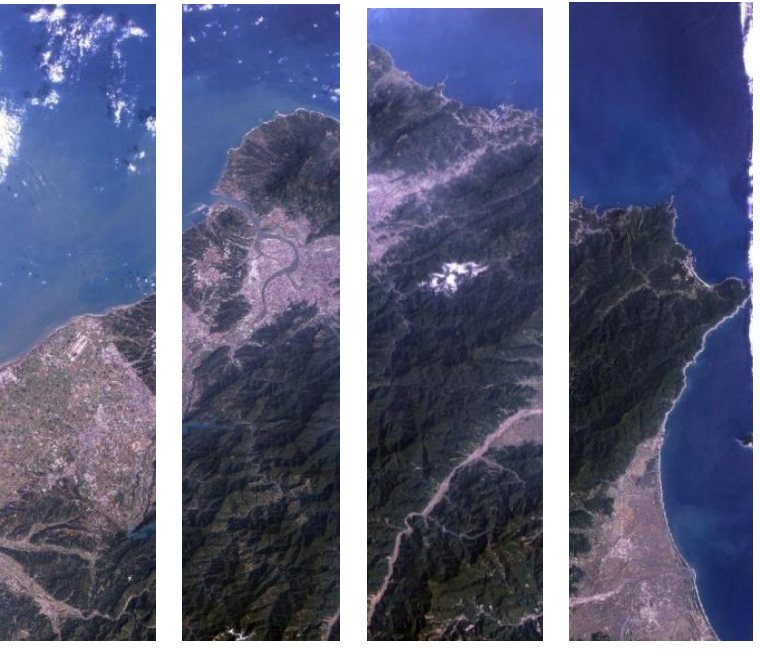
Figure 2. The satellite image bands from